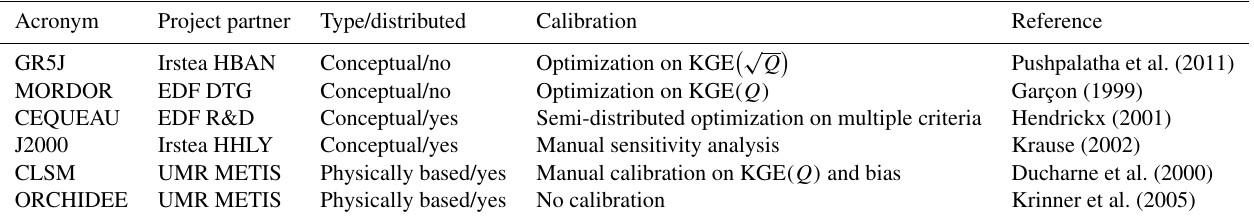
Table 3. HM characteristics. KGE refers to the Kling–Gupta efficiency (Gupta et al., 2009). Acronym